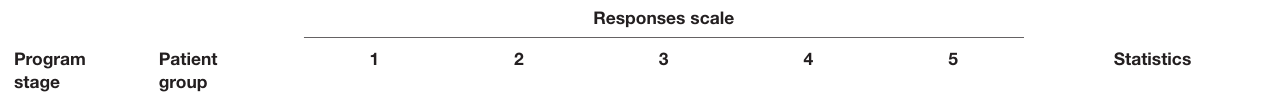
TABLE 5 | Asthma Control Test (ACT) descriptive